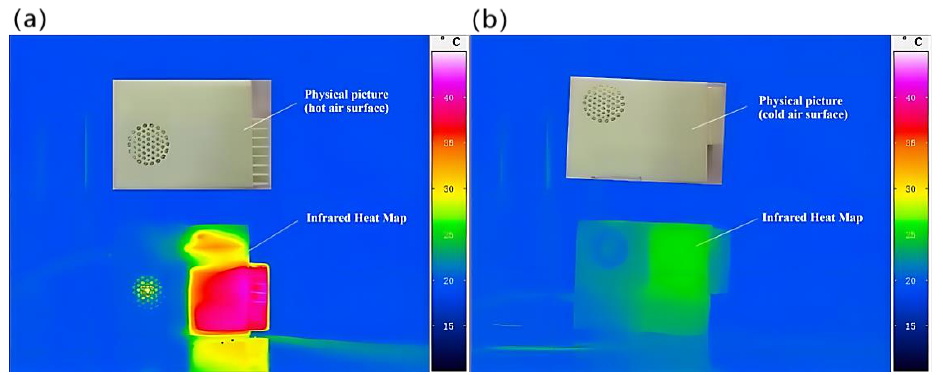
Figure 16. Temperature distribution results measured by infrared thermal imaging camera. ( a ) Heat map of the temperature distribution on the hot air surface of the portable refrigeration device. ( b ) Heat map of the temperature distribution on the cold air surface of the portable refrigeration device.